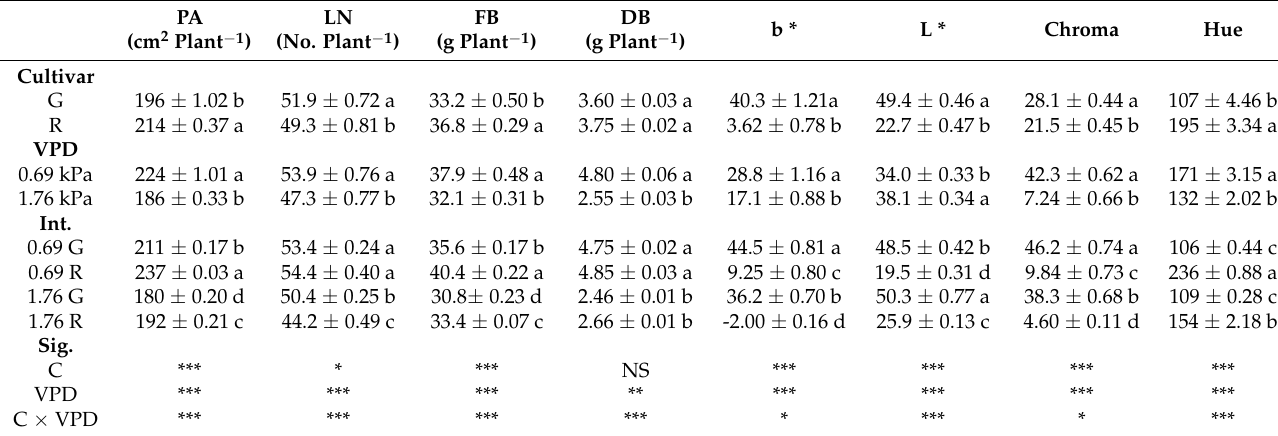
Table 1. Growth analyses consisting of plant area (PA), leaf number (LN), fresh biomass (FB), dry Biomass (DB), and leaf colorimetry coordinates (L*, Chroma and Hue angle) in green (G) and red (R) lettuce plants grown under the two Vapor Pressure Deficit (VPD) levels (0.69 and 1.76 kPa).